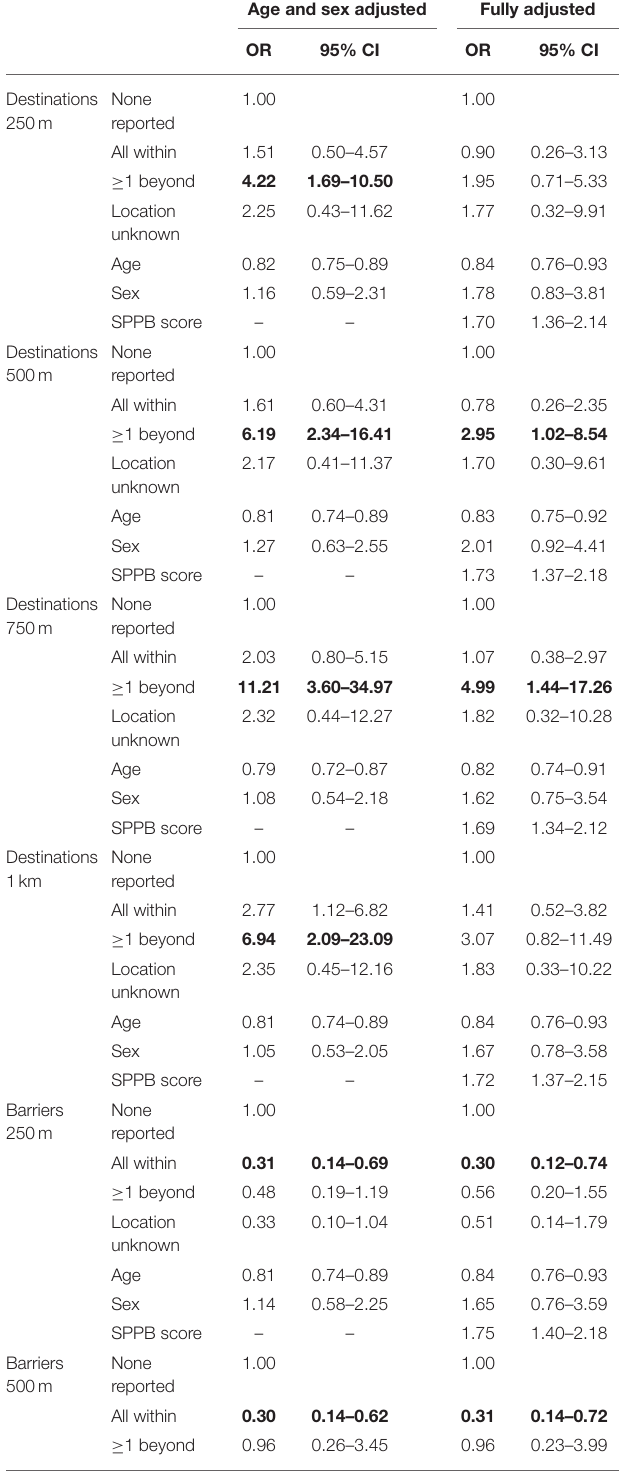
TABLE 4 | Logistic regression models of neighborhood destinations and barriers to outdoor mobility categorized by distance from home and odds ratios (OR) for higher physical activity ( n =